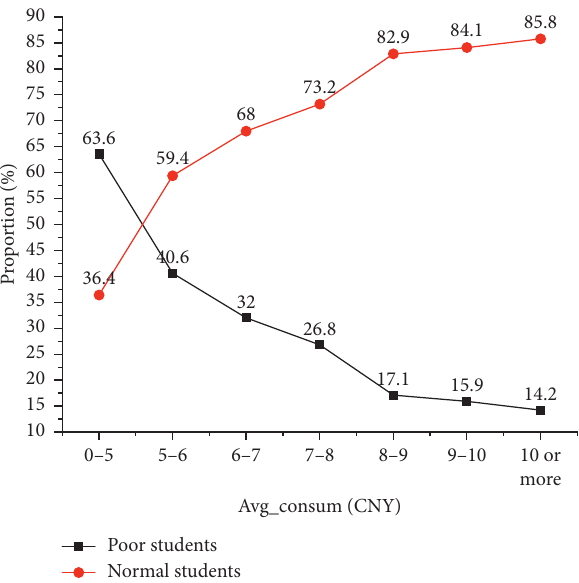
Figure 6: Proportion of poor students in different average con- sumption